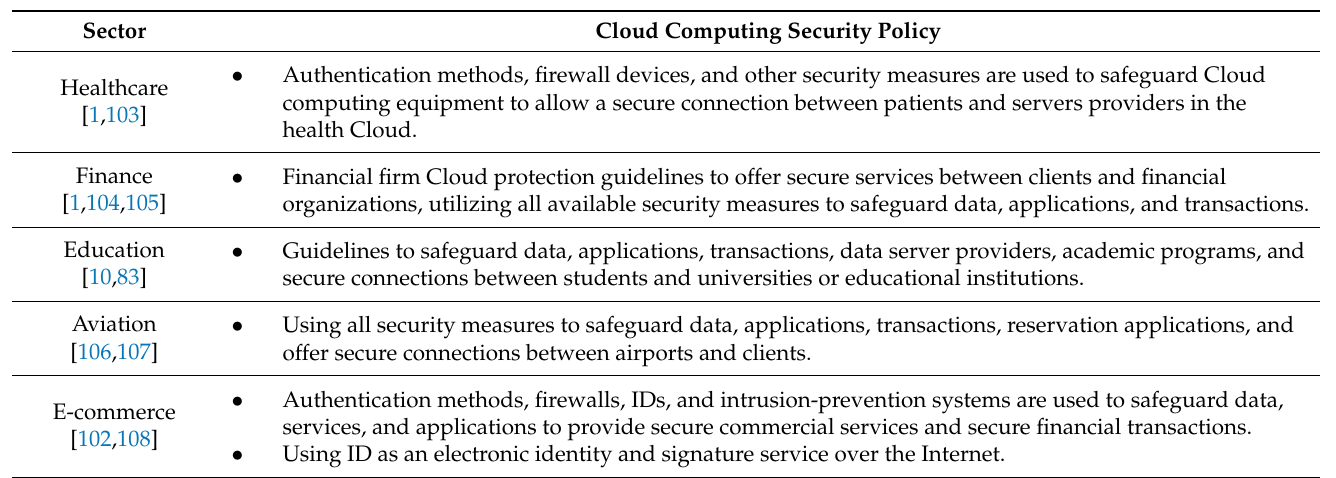
Table 4. Cloud computing security policy among different